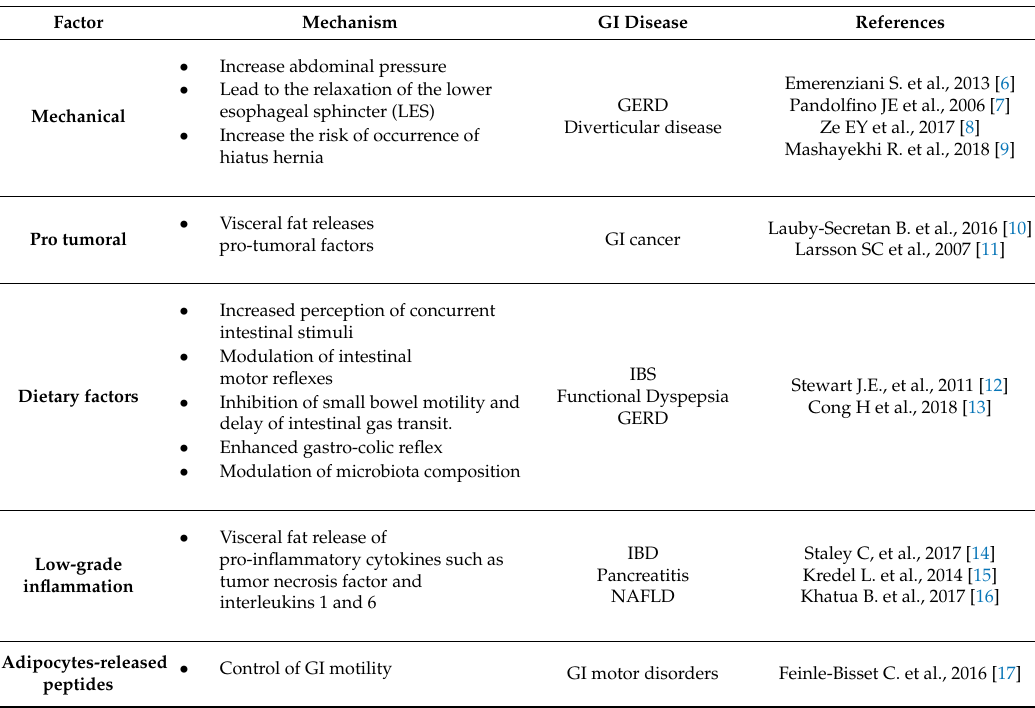
Table 2. Some of the mechanisms linking obesity and GI disease.